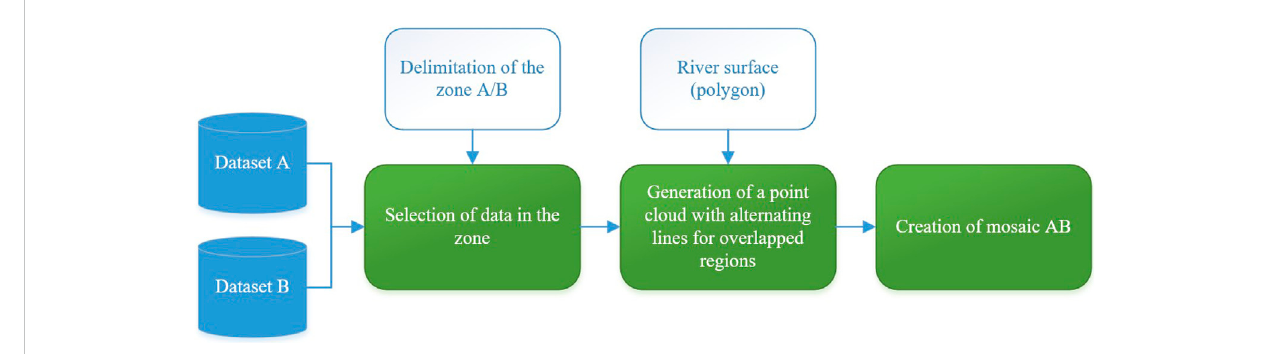
FIGURE 4 Main steps involved in the feathering method to combine heterogeneous